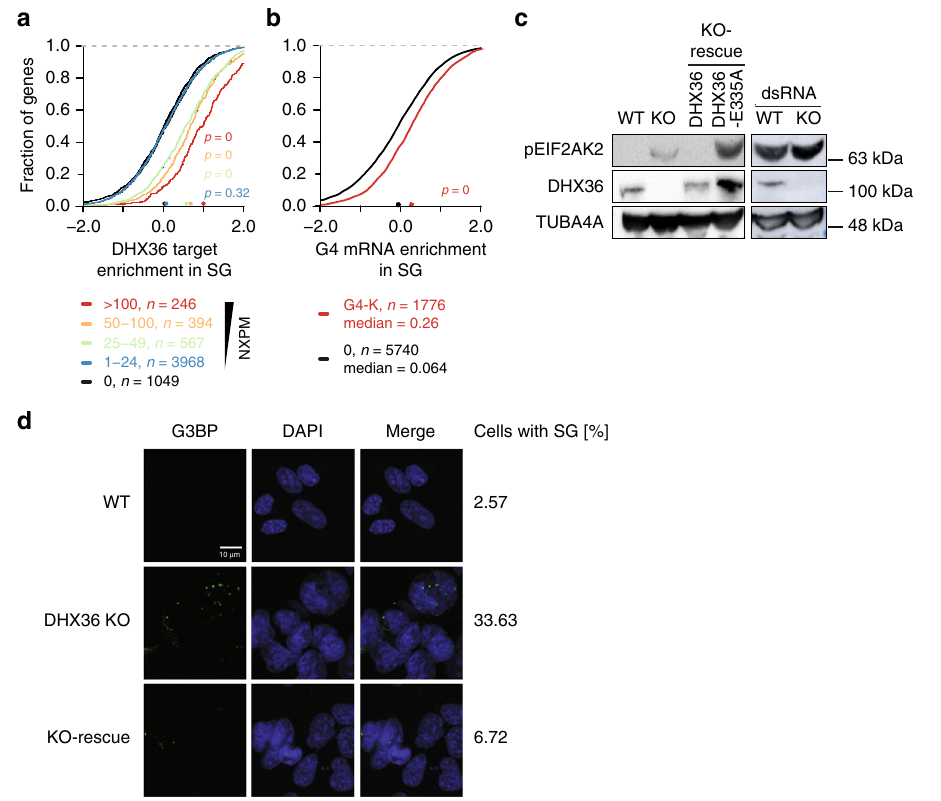
Fig. 7 DHX36 mRNA targets are enriched in stress granules. a Cumulative distribution function showing enrichment of DHX36 mRNA target levels in stress granules compared to non-targets. Target mRNAs are binned in accordance to the number of NXPM obtained by DHX36-E335A PAR-CLIP. Signi fi cance was determined using a two-sided KS test. b Cumulative distribution function showing enrichment of G4-forming DHX36 mRNA target levels in stress granules compared to non-targets. Target mRNAs are binned based on whether they harbor a G4-site identi fi ed previously 10 overlapping with PAR-CLIP binding sites or not. Signi fi cance was determined using a two-sided KS test. c Western blot analysis of wild-type HEK293 cells (WT),